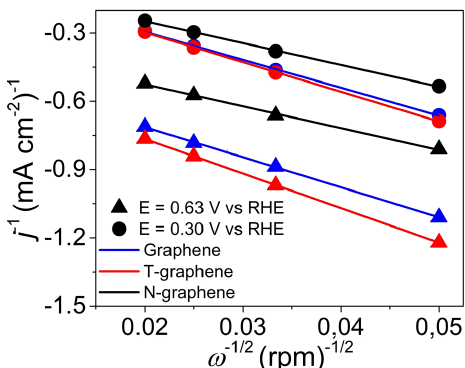
Figure 8. Koutecký-Levich plots of the